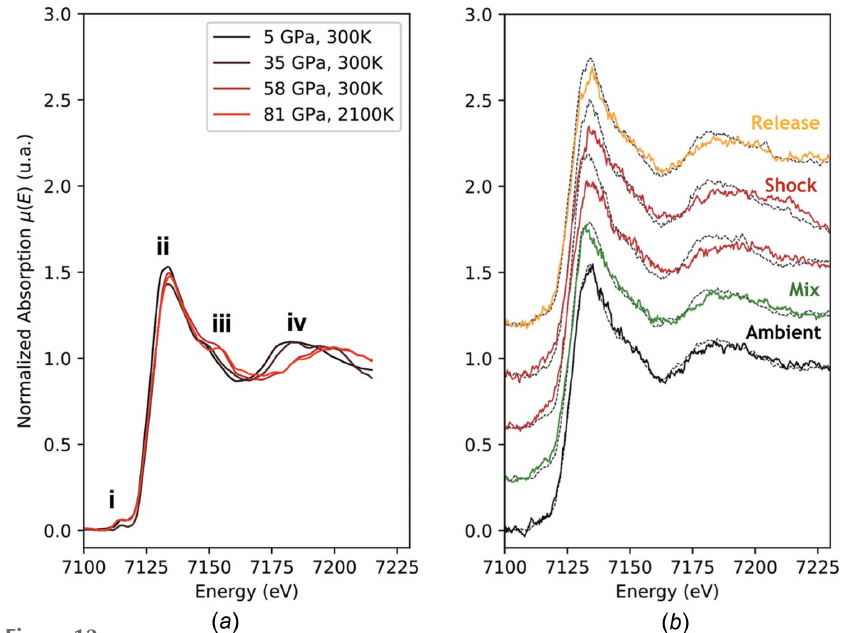
Figure 12 ( a ) X-ray absorption spectra of Fe 2 O 3 at pressures of 5, 35 and 59 GPa and ambient temperatures, and at 81 GPa and 2100 K, using the LH-DAC apparatus at ESRF ID-24 (Boulard et al. , 2019). ( b ) X-ray absorption spectra of Fe 2 O 3 under shock at an estimated pressure and temperature of 120 GPa and 1500 K, and under adiabatic release at ambient pressure and 1000 K (SESAME EOS 7440). The black dotted spectrum is the ambient